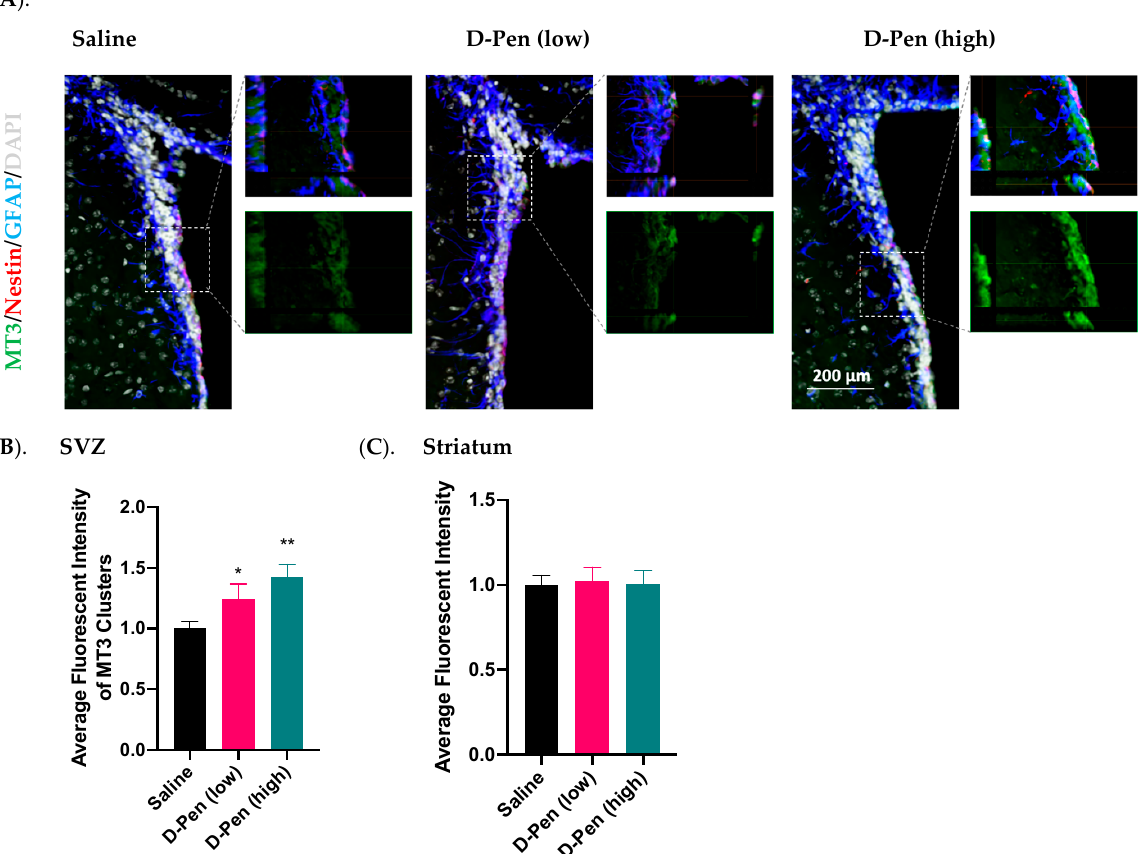
Figure 11. Expression of MT3 in SVZ and striatum following long-term ICV D-Pen infusion. ( A ) MT3 expression in the SVZ and colocalization with adult NSPCs. MT3 enrichment in the SVZ was further 3D-magnified for improved observations. Scale bar = 200 μ m. ( B ) Quantification of MT3 immunofluorescent intensity in SVZ using multiple slices per brain. ( C ) Quantification of MT3 immunofluorescent intensity in striatum using multiple slices per brain. For panels ( B , C ), data represent mean ± SD, n = 3/group. * p < 0.05, ** p < 0.01, as compared with the controls.